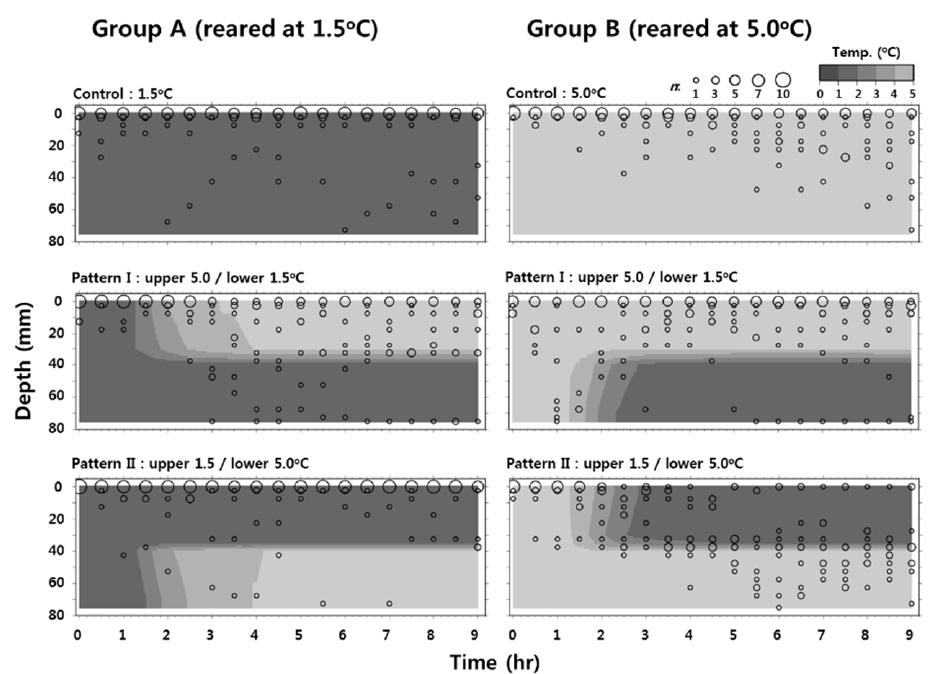
Figure 7. Relative number (%) of newly hatched walleye pollock larvae in the three hydrographic patterns; average calculated from six replicates ( n = 610).